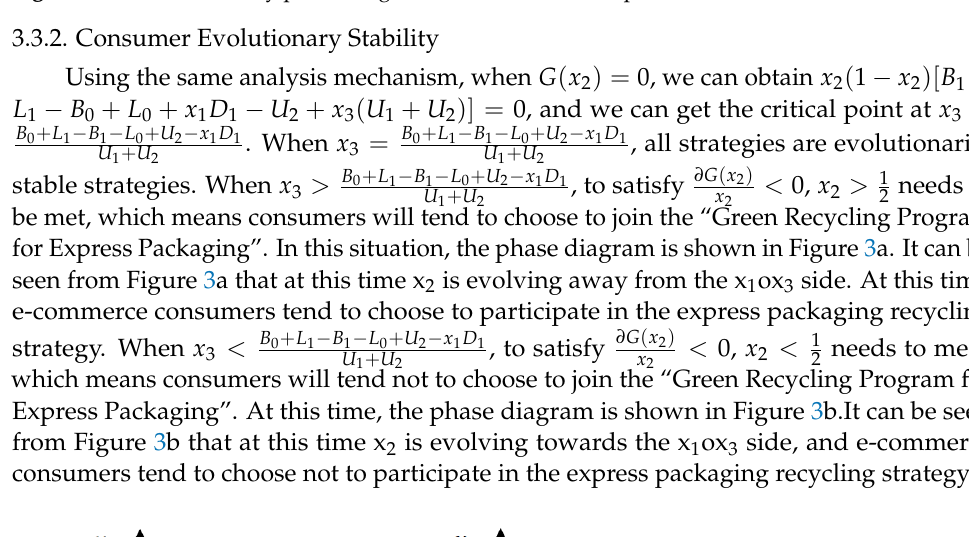
Figure 2. The evolutionary phase diagram of the e-commerce platform.